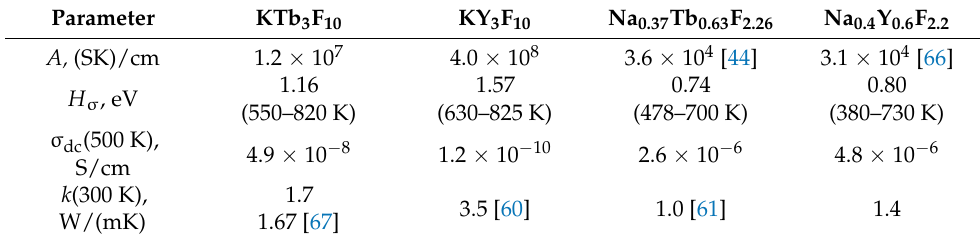
Table 2. Physical properties of K R 3 F 10 and Na 0.5–x R 0.5+x F 2+2x ( R = Tb, Y)